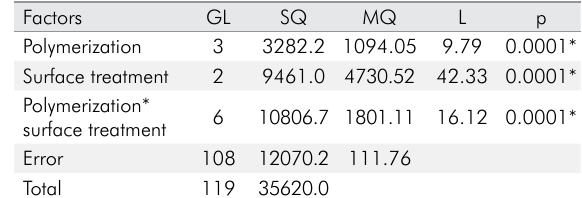
Table 5. ANOVA results for the “polymerization” and “surface treatment” factors according to the degree of conversion (*p <0.05).